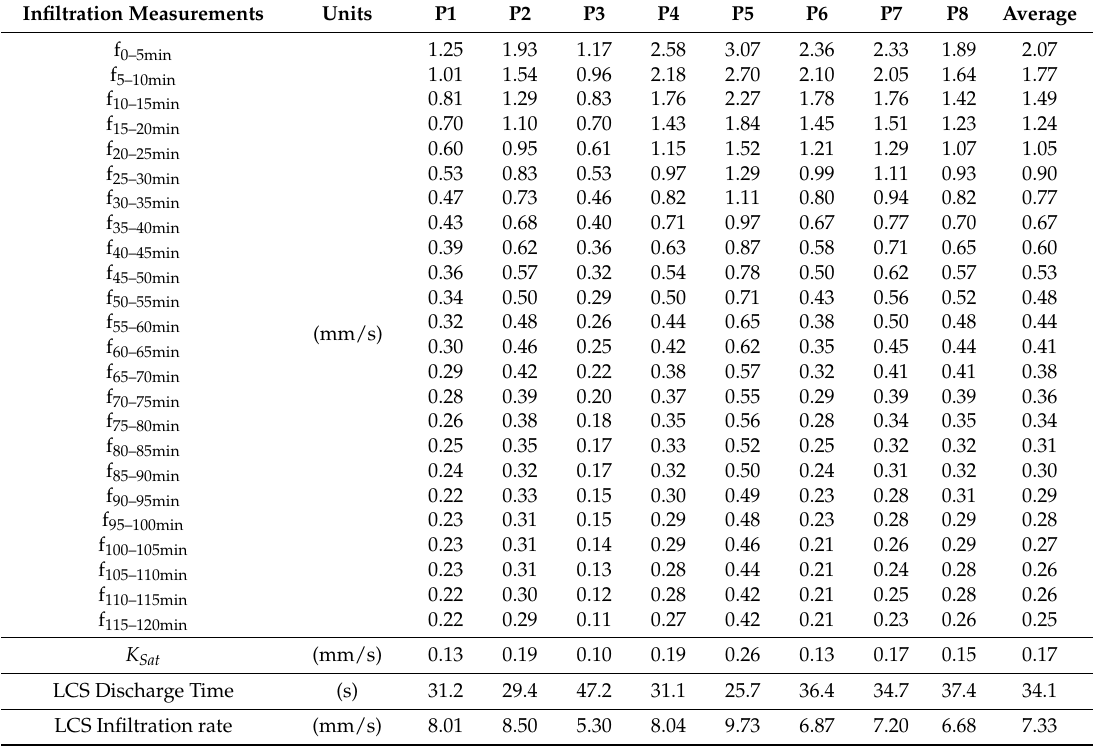
Table 2. Infiltration test results for clogged porous concrete (PC) specimens. Results are unsaturated infiltration rates at different times of the unsaturated constant head experiment and P1 through P8 indicate the tested specimens. The saturated value ( K Sat ) indicates results from the saturated constant head experiment and the LCS discharge time and equivalent infiltration